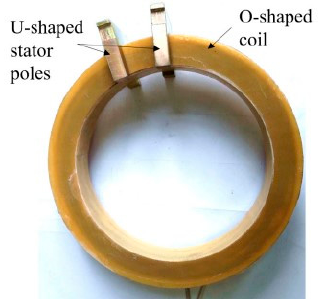
Figure 11. Physical model of the O-shaped phase coil with a height of 20 mm.